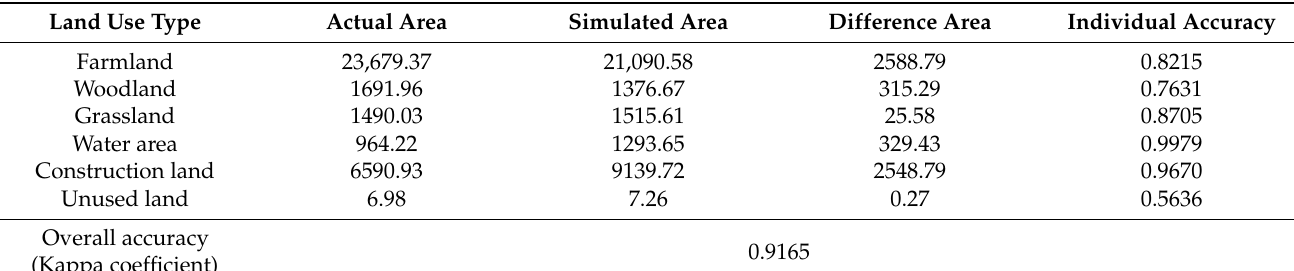
Table 5. Land use simulation accuracy evaluation for 2015 (unit: km 2